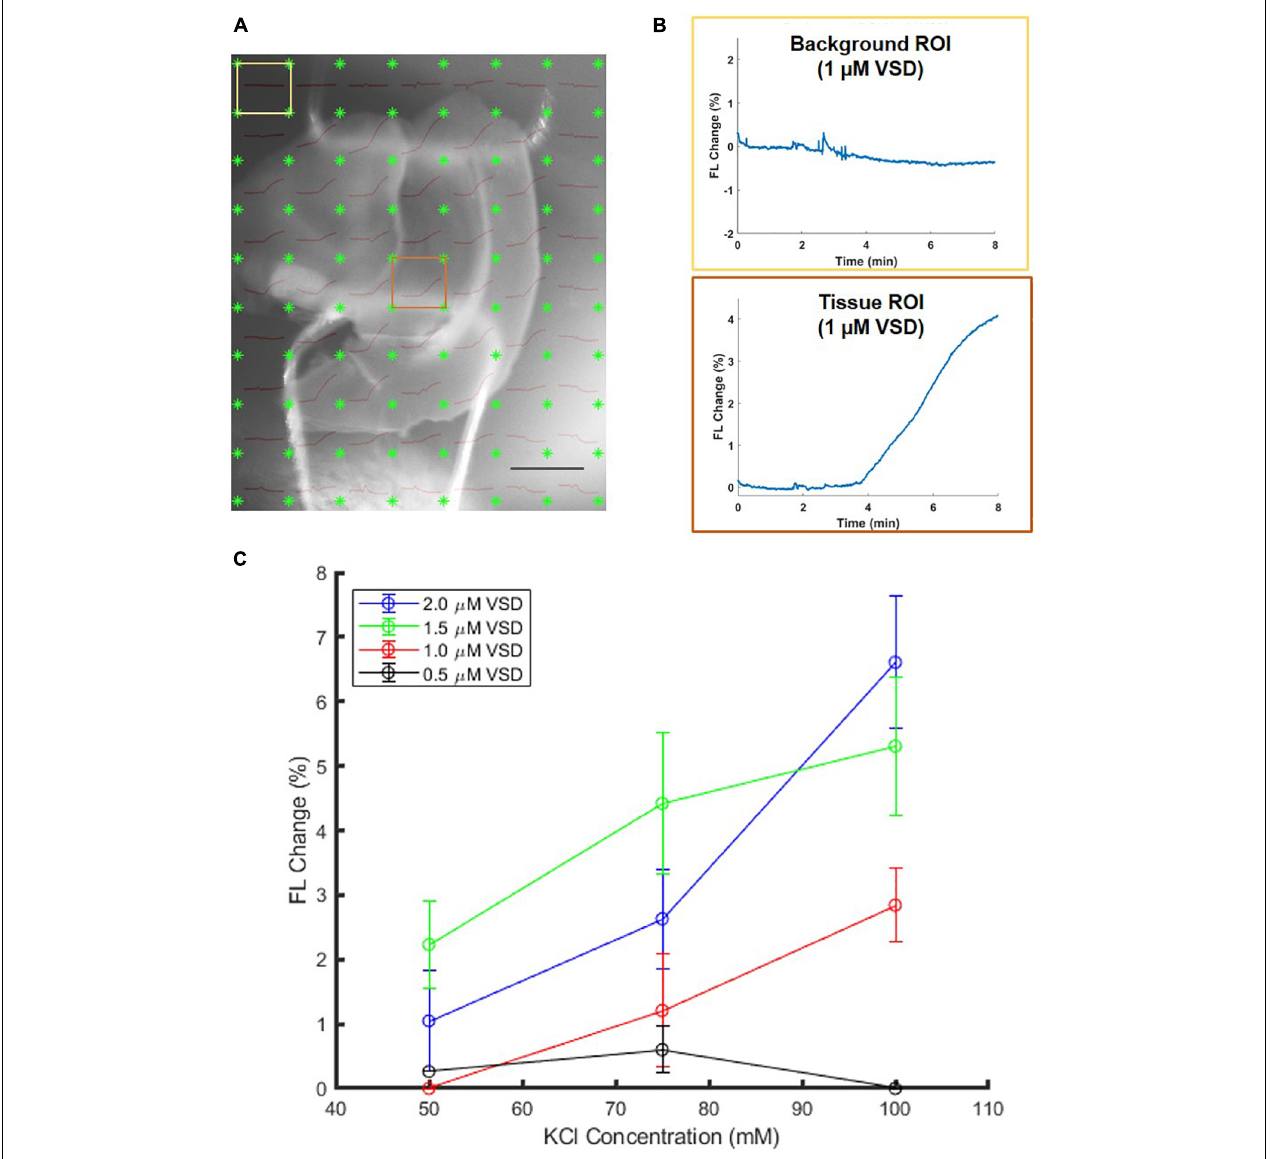
FIGURE 5 | Sample 1- µ M stained brain slice (A) anatomical image overlaid with fluorescence trace plots for each ROI. (B) The presence of differences in background and tissue ROI fluorescence change curves allows identification of minimum VSD concentration thresholds to achieve evoked responses. Scale bar = 2 mm. (C) Comparison of brain slices stained from 0.5 to 2.0 µ M VSD at different stimulation strengths (KCl concentrations) indicates that with higher VSD concentration in the tissue, the difference in responses to different stimulation strengths is also